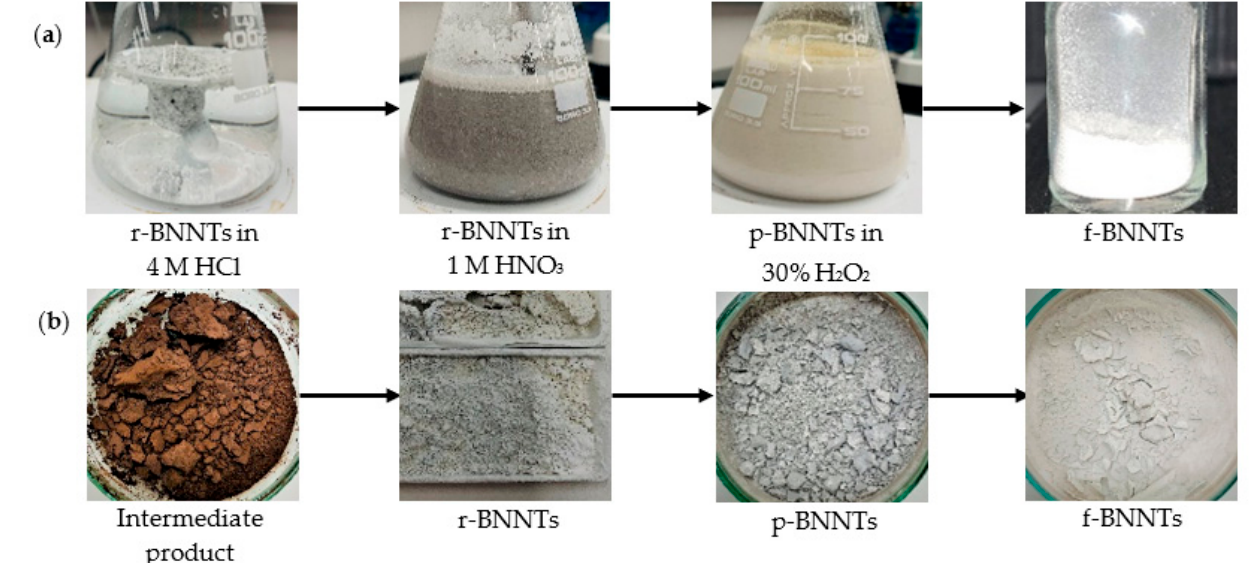
Figure 2. ( a ) Process of BNNTs’ purification and functionalisation; ( b ) colour change of BNNTs from intermediate to final stage. intermediate to final